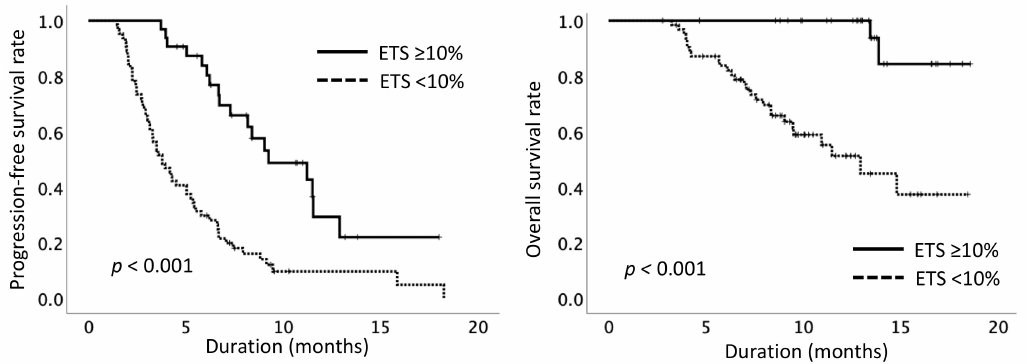
Figure 3. Cumulative progression-free survival and overall survival rates according to early tumor shrinkage. ETS, early tumor shrinkage.